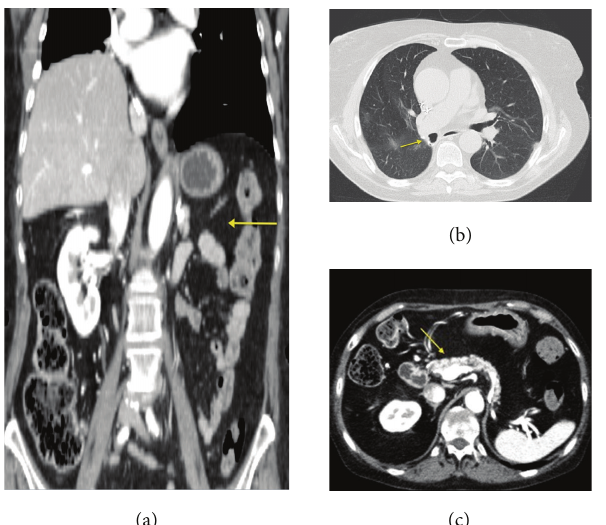
Figure 5: Images show the absence of local relapses after the surgery in the left kidney (a) and in the lung (b); the hypodense pancreatic lesion was not more detectable at the pancreatic istm and no other pancreatic lesions were seen (c). (a) CECT-MPR-Coronal Plane. (b) CECT-Axial. Lung Window. (c) CECT-Axial. Arterial